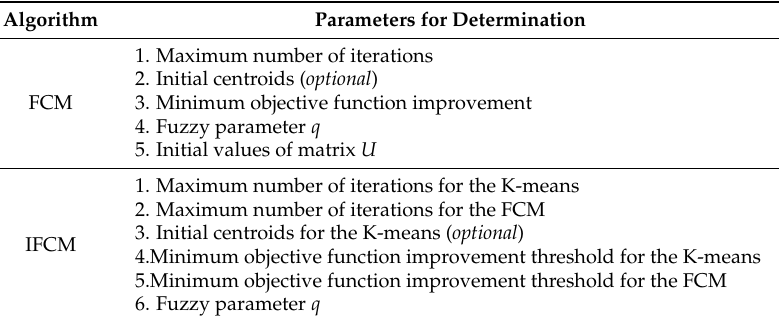
Table 4. Parameters of the fuzzy algorithms.